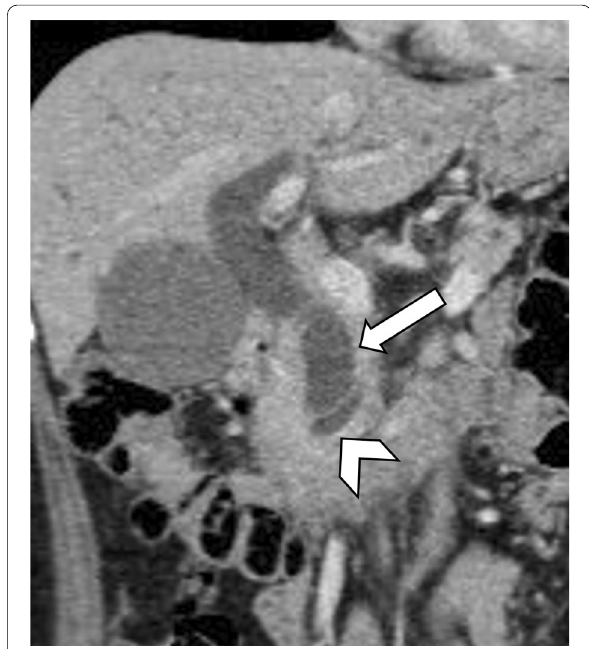
Fig. 5 Metastatic ILC of the pancreas in a 53-year-old female presenting with painless jaundice. She was on adjuvant letrozole for Stage 2 ILC of the left breast diagnosed 2 years ago. Coronal contrast-enhanced CT image shows a dilated common bile duct (white arrow) and dilated pancreatic duct (arrowhead)—the double duct sign. The intrahepatic ducts are also mildly dilated. No discrete mass is seen in the pancreatic head on CT or on EUS. Metastatic involvement of the pancreatic head was confirmed on intra-operative